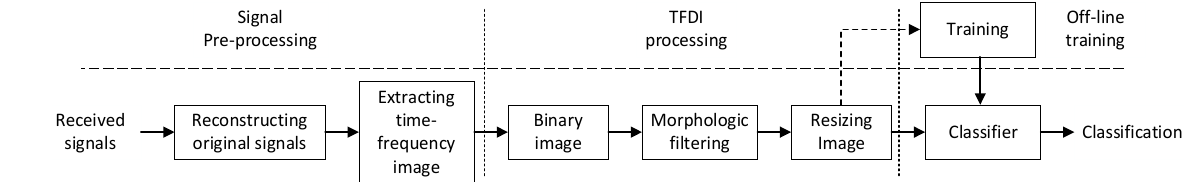
Figure 2. The structure diagram of the recognition system.